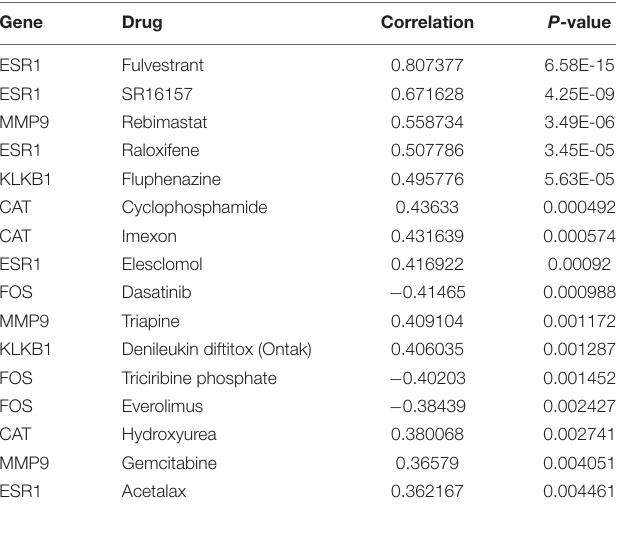
TABLE 1 | Correlations of the six characteristic immune-related genes (IRGs) with anti-cancer drugs sensitivity based on the CellMiner